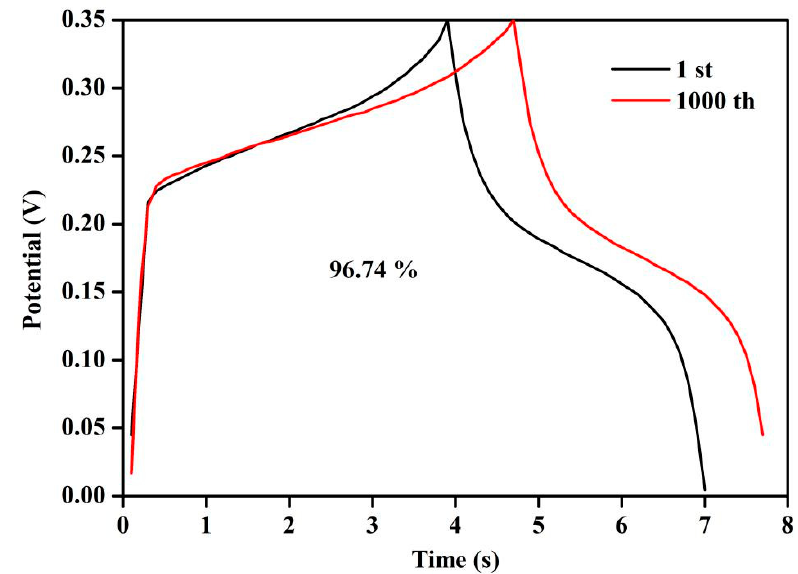
Figure 9. GCD curves at 1st and 1000th cycles of LC/ZnO-550 °C composite.